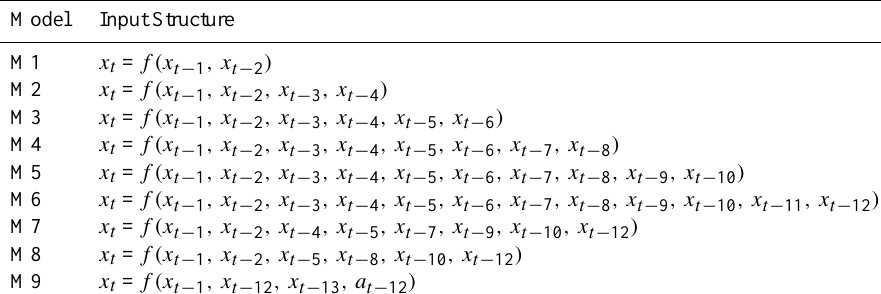
Table 2. The Input Structure of the Models for Forecasting of Selangor River Flow.